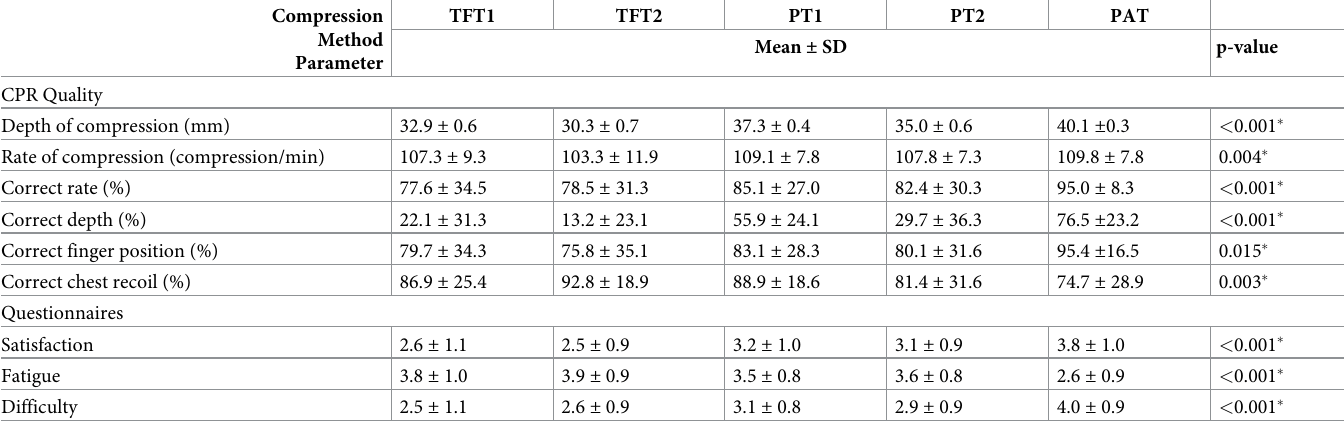
Table 1. Comparisons of chest compression quality of the five different